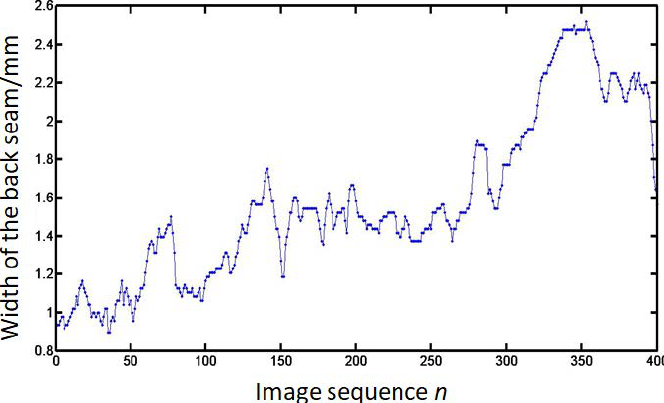
Fig. 9 Widths of weld seam on the back